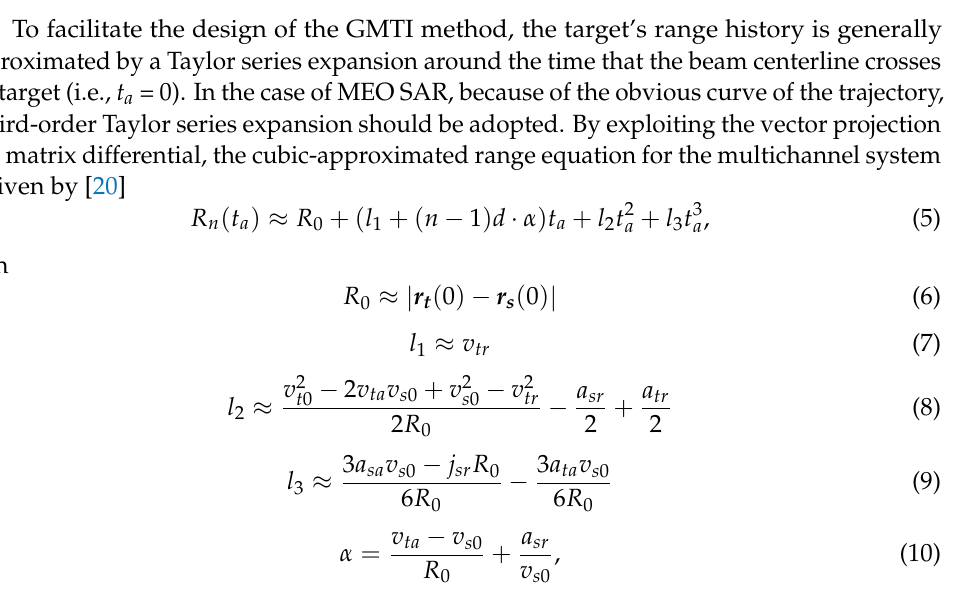
where v s 0 = | v s (0)| and v t 0 = | v t (0)| are, respectively, the velocities of the radar and target at t a = 0. In addition , v tr and a tr represent the target’s radial velocity and acceleration; v sr , a sr and j sr are, respectively, the radial projections of the radar’s velocity, acceleration and jerk; v ta and a ta define the target’s along-track velocity and acceleration; a sa is the radar’s acceleration. They can be expressed as [20]